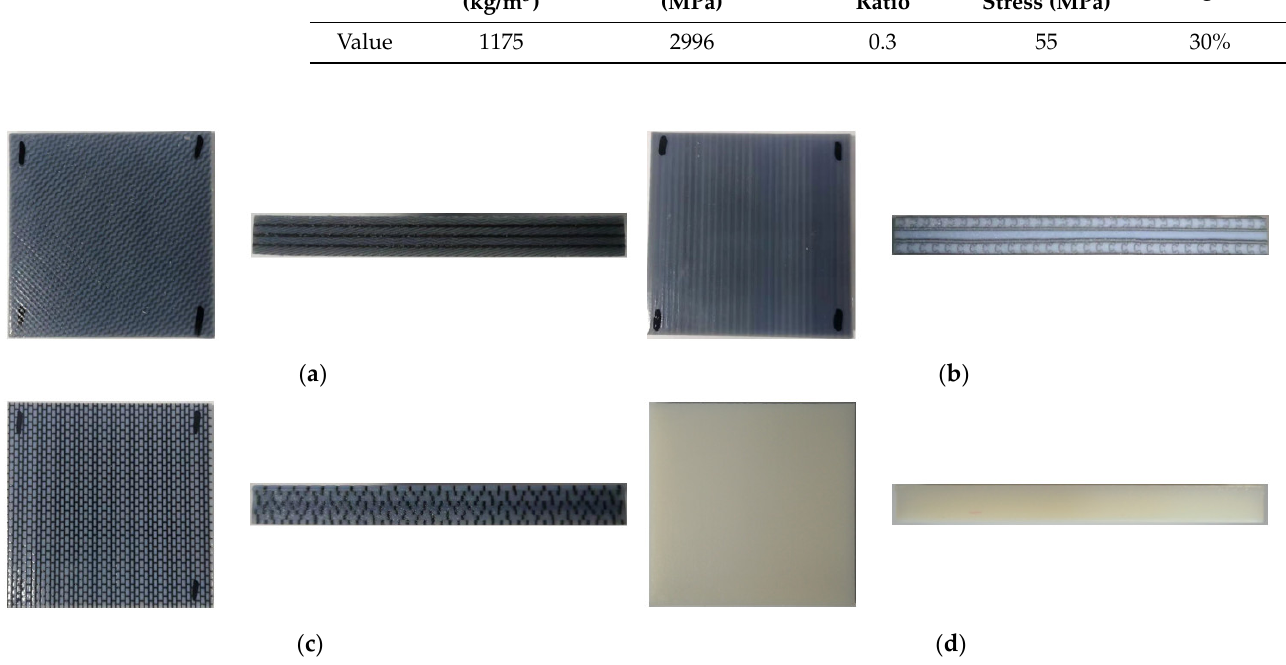
Figure 5. Specimen of each structure: ( a ) Bio-S (0°/90°/0°/90°); ( b ) Bio-B (0°/90°/180°); ( c ) Bio-N; ( d ) Figure 6. Specimen of each structure: ( a ) Bio-S (0 ◦ /90 ◦ /0 ◦ /90 ◦ ); ( b ) Bio-B (0 ◦ /90 ◦ /180 ◦ ); ( c ) Bio-N; MSP. ( d )